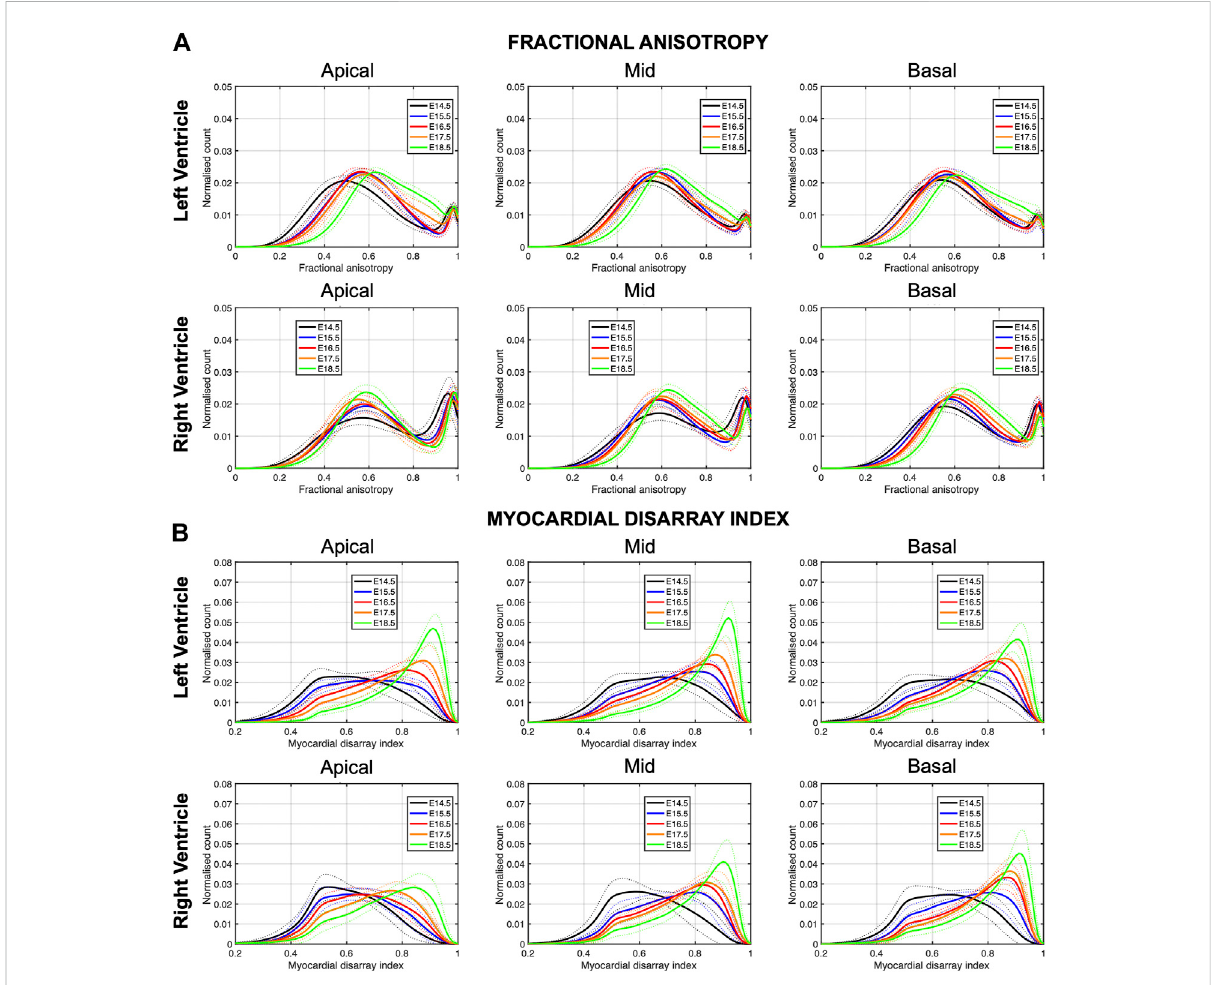
FIGURE 6 Histograms of (A) fractional anisotropy (FA) and (B) myocardial disarray index (MDI) across the apical, mid-ventricular and basal LV and RV of murine hearts at E14.5, E15.5, E16.5, E17.5 and E18.5 days of development. Solid lines: age-group mean. Dotted lines: ± standard deviation.